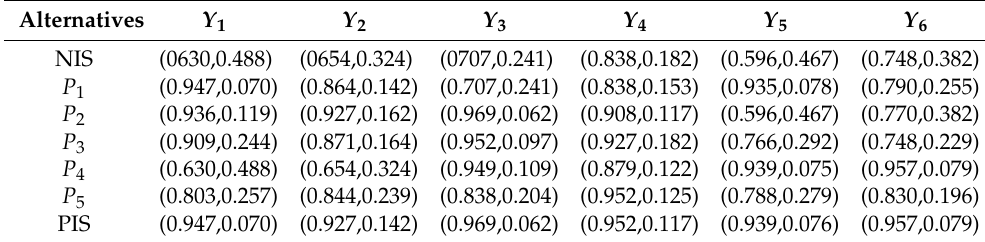
Table 7. The extended PyFDM of WCRCs.